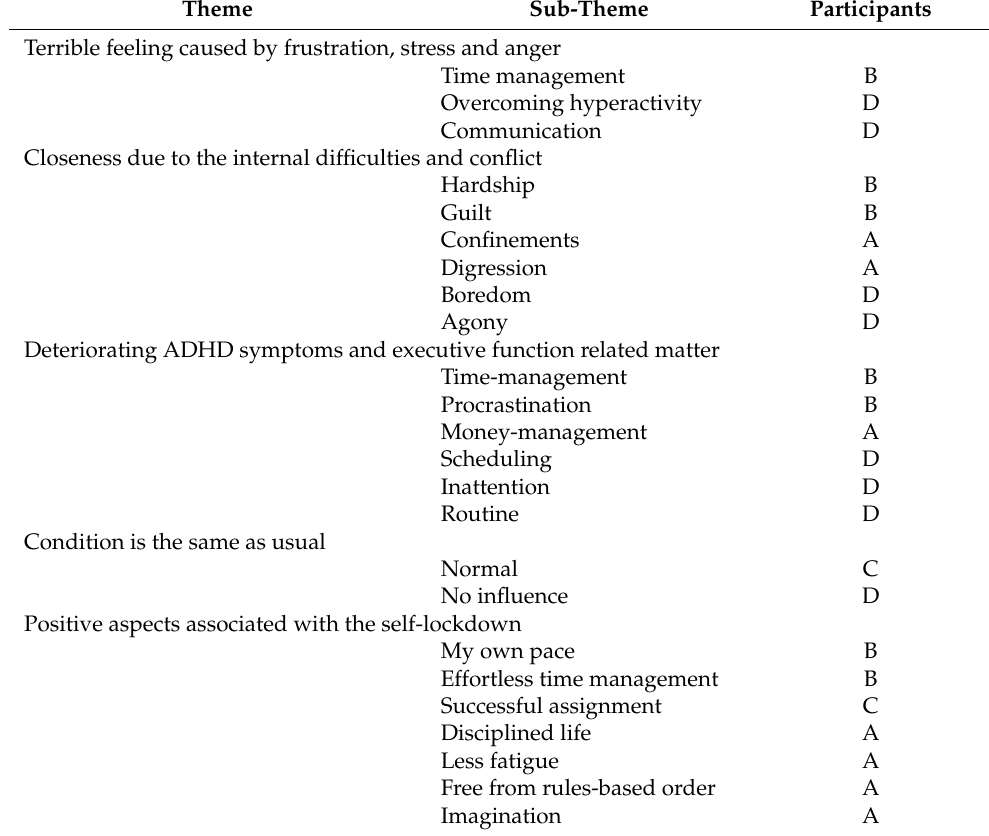
Table 2. Theme and